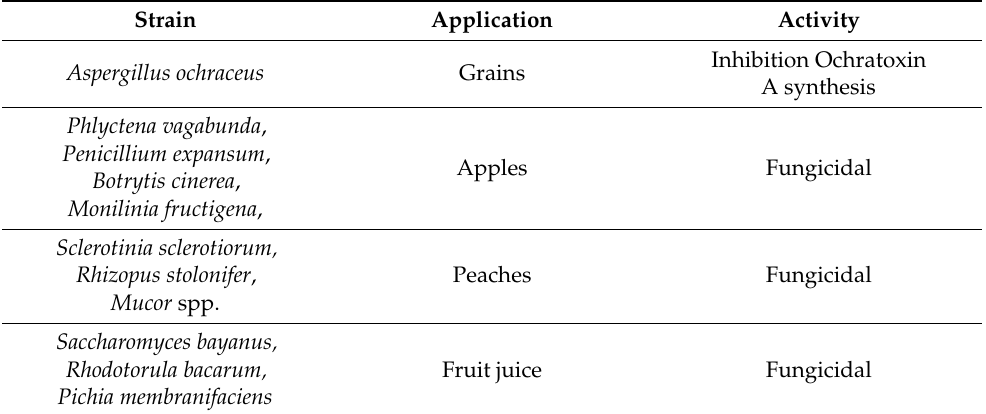
Table 2. Effects of eugenol in agriculture on various pathogens